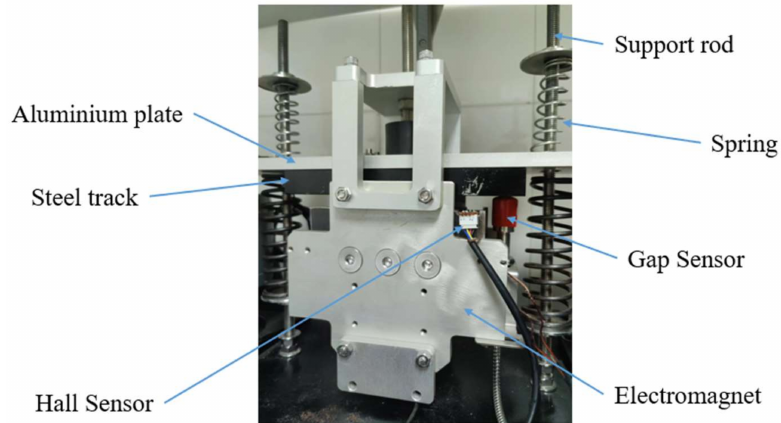
Figure 12. Picture of the magnetic suspension experimental